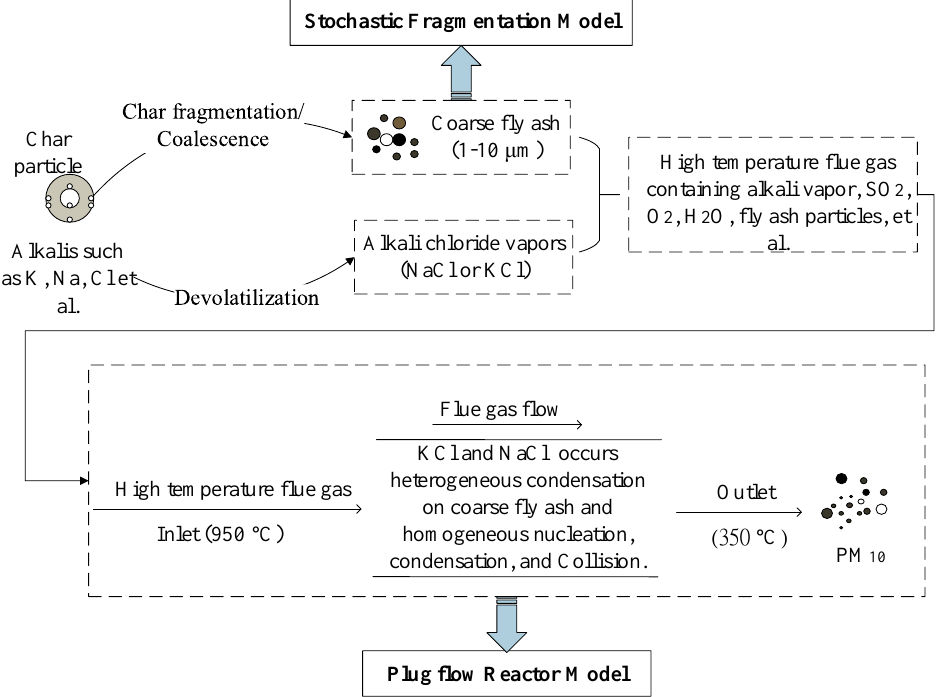
Figure 1. Main processes of ash formation during pulverized biomass combustion.